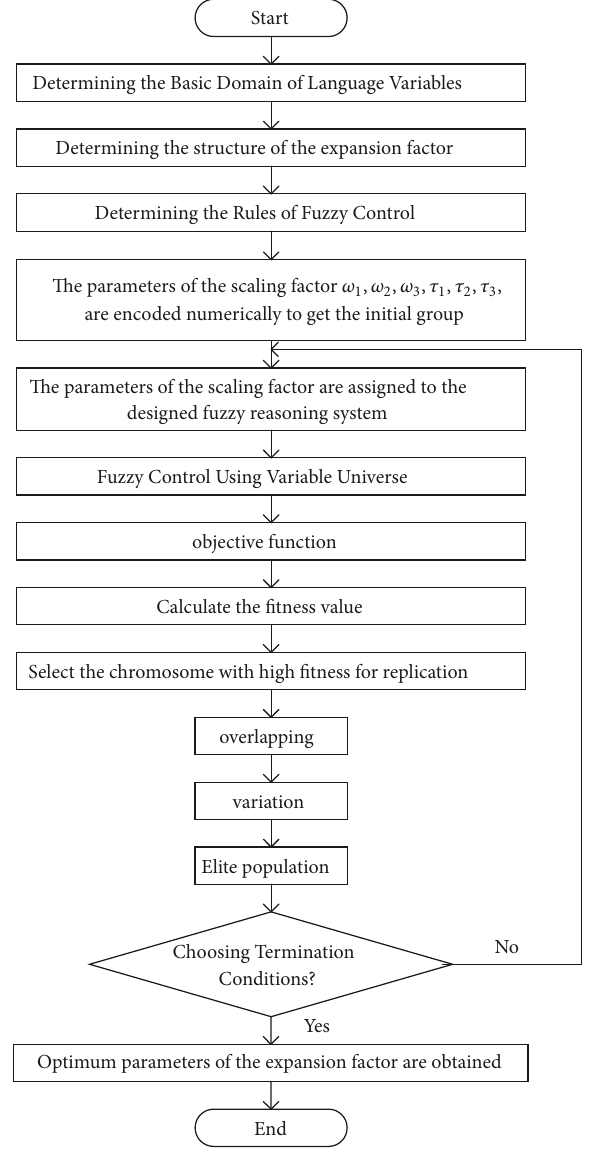
Figure 6: Schematic diagram of the MPGA